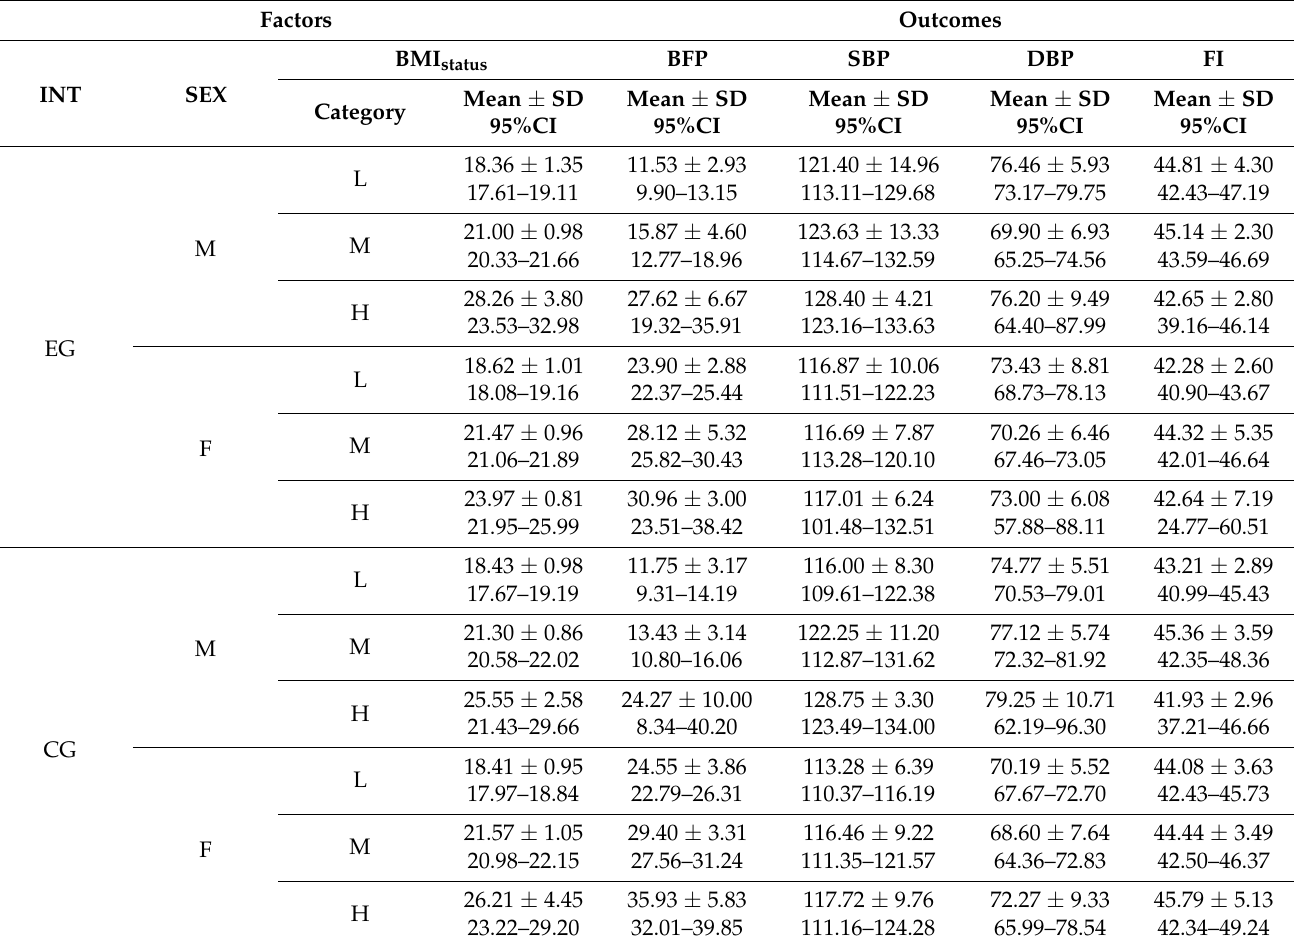
Table 1. Descriptive statistics of dependent variables (body fat percentage (BFP), resting systolic and diastolic blood pressure (SBP, DBP), and fitness index (FI)) in categories of factors (intervention (INT), sex (SEX), and body mass index intervals (BMI status